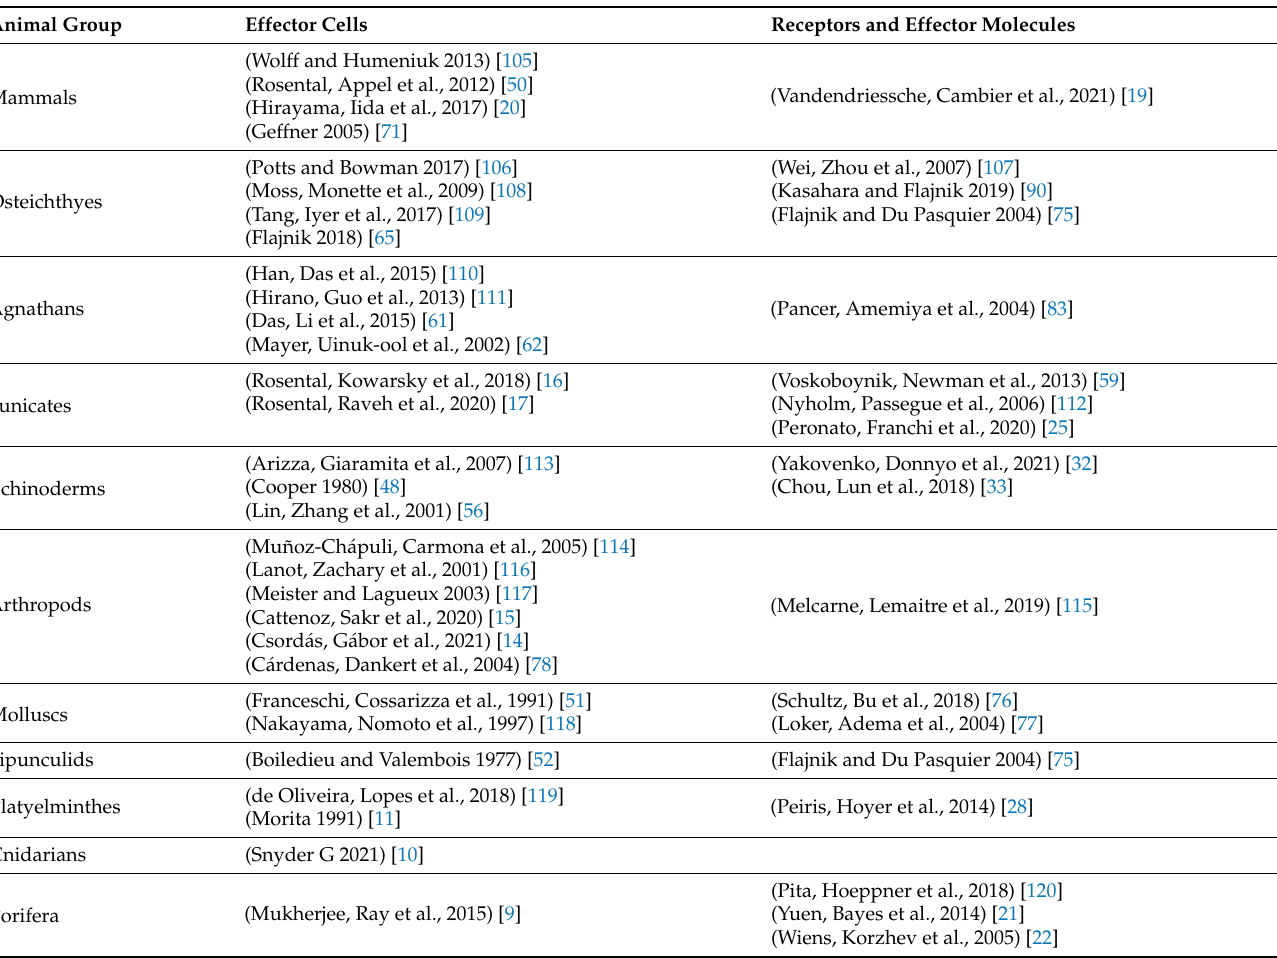
Table 1. Data sources for Figure